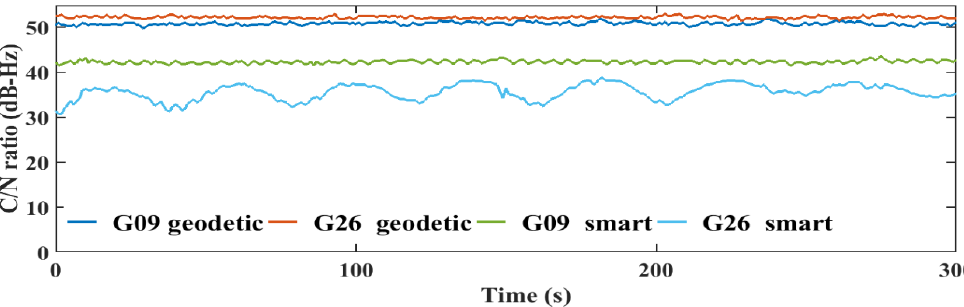
Figure 8. L1 C/N values from the geodetic receivers (geodetic) and the smartphone (smart) for GPS.